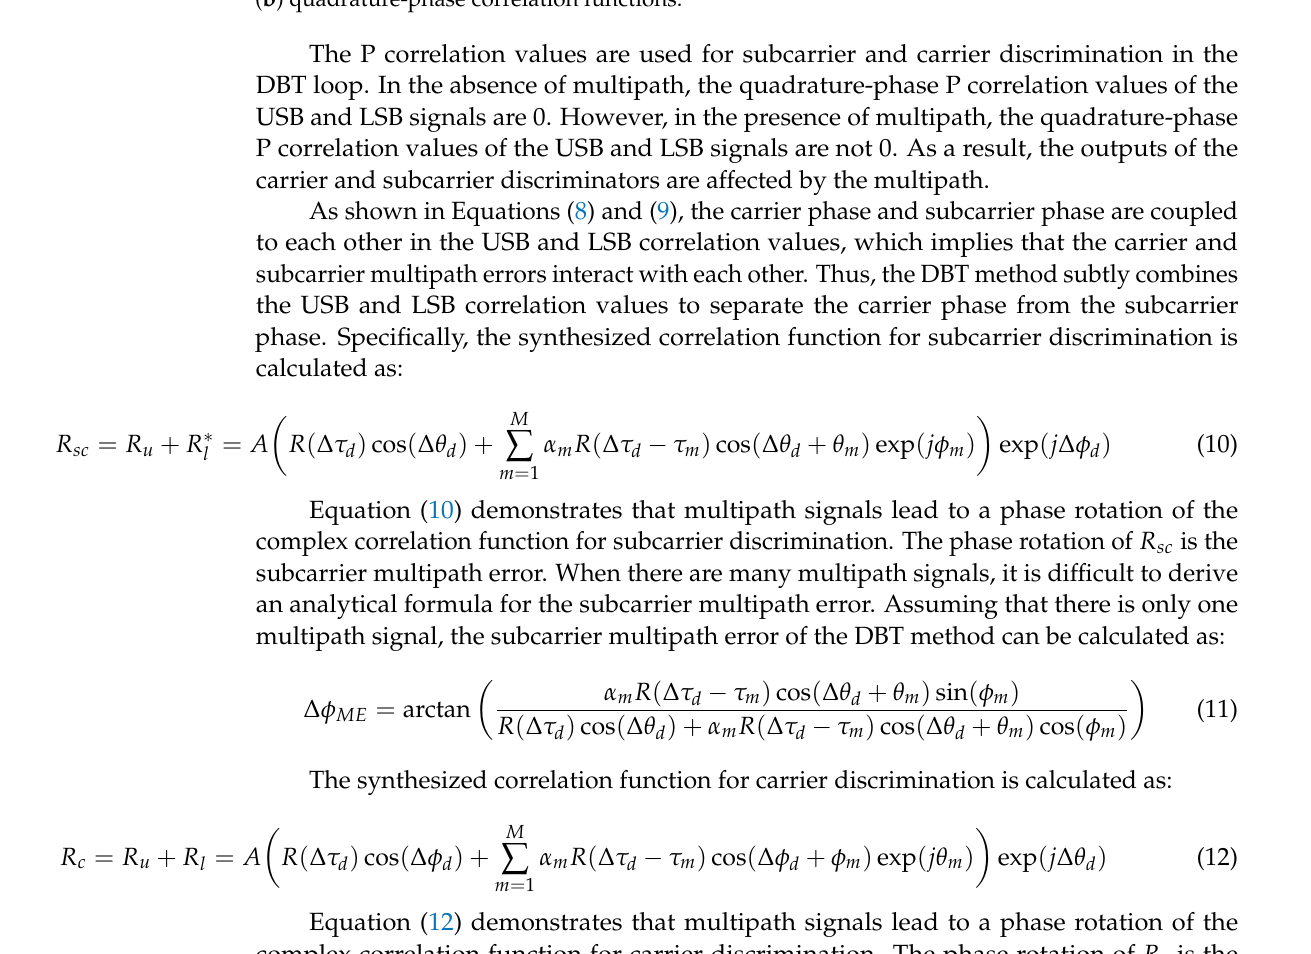
Figure 2. Normalized correlation functions for each single sideband of the BOC(15, 2.5) signal, where E, P, and L denote early, prompt, and late correlators, respectively: ( a ) in-phase correlation functions; ( b ) quadrature-phase correlation